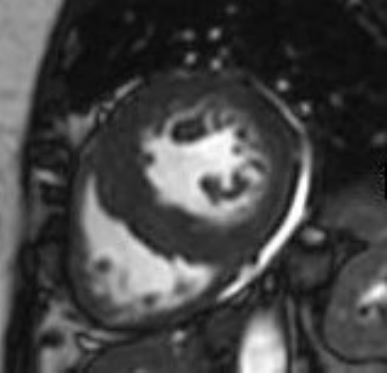
Figure 1. Concentric hypertrophy in an obese adolescent.